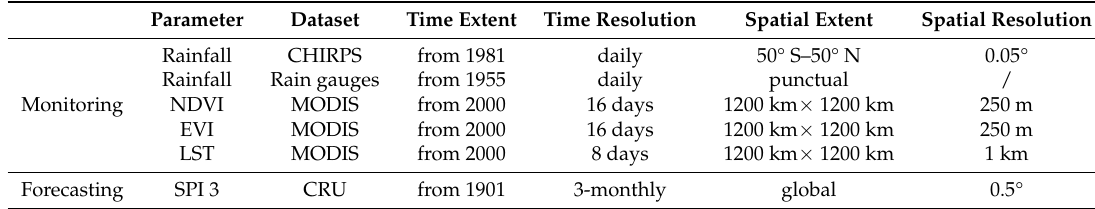
Table 1. Datasets used in the monitoring and forecasting framework.